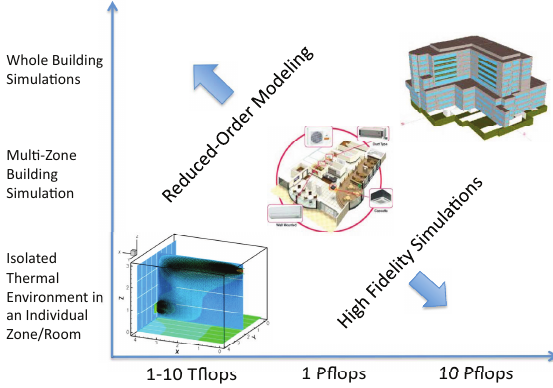
Figure 1. Simulation requirements in a building. Reproduced with permission from